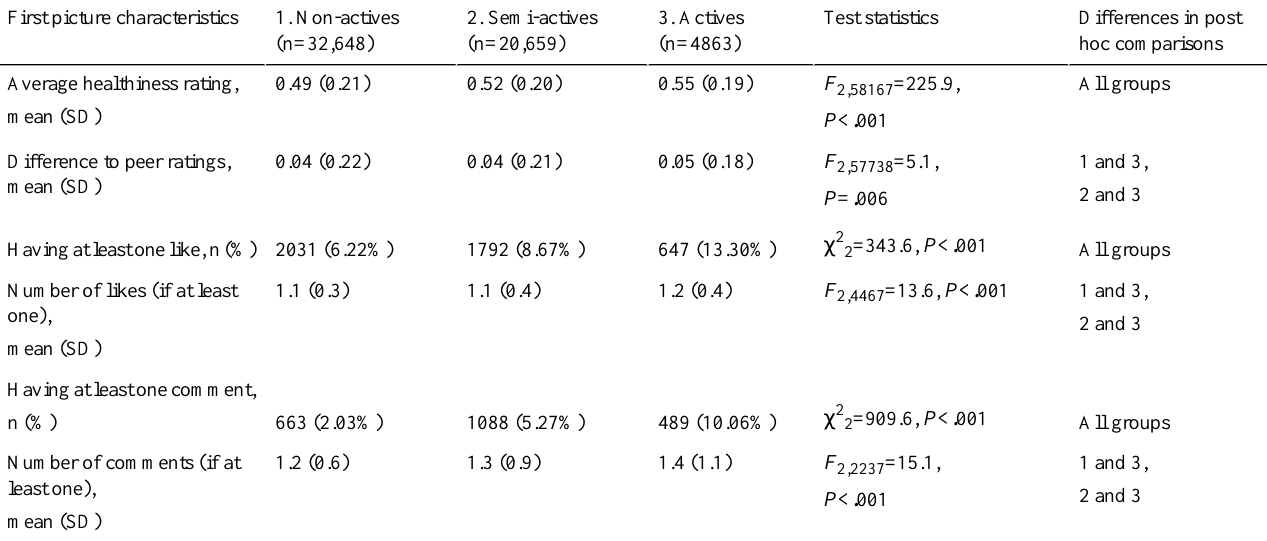
Table 7. Amount and quality of peer feedback for the initial self-monitoring record in the app between different adherence groups.